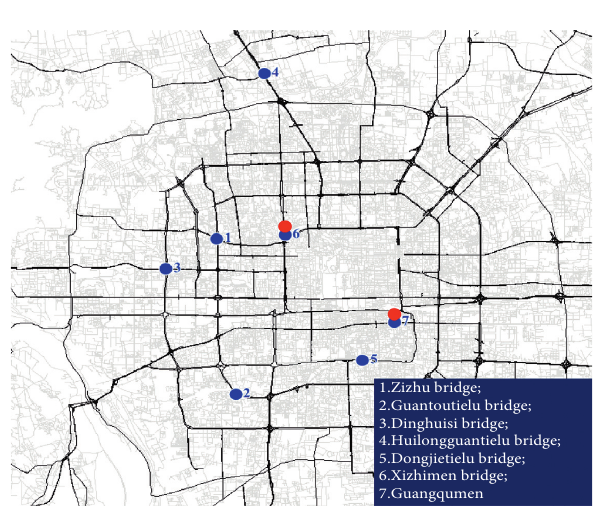
Figure 4: The expressway network studied and the distribution of water accumulation